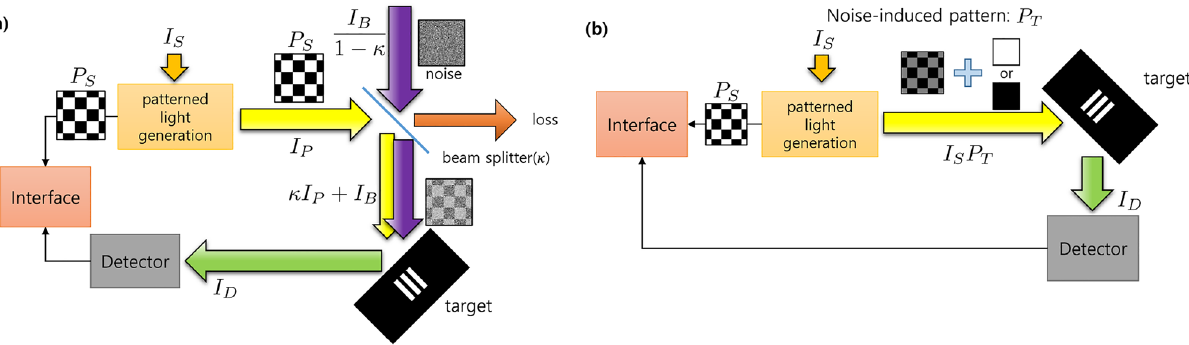
I S P S ( � x ) d � x , and that of environmental noise is A A (cid:31)